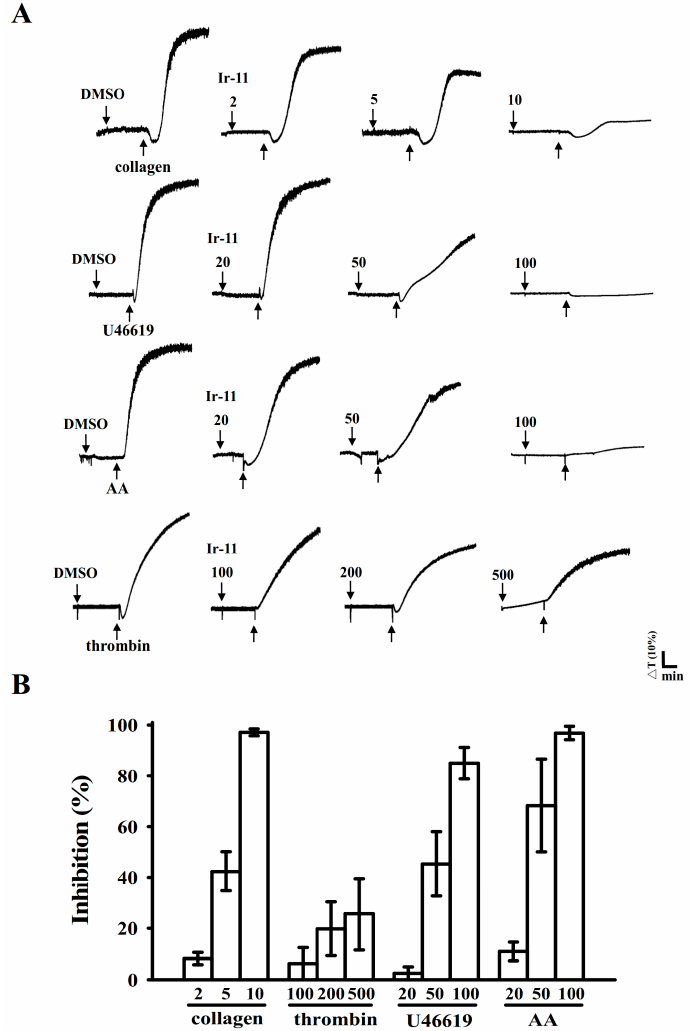
Figure 2. Comparison of the relative inhibitory activity of Ir-11 against platelet aggregation stimulated by various agonists in washed human platelets. ( A ) Washed human platelets (3.6 × 10 8 cells/mL) were preincubated with the solvent control 0.1% DMSO or various concentrations of Ir-11 (2–500 µ M) and subsequently treated with collagen (1 µ g/mL), thrombin (0.01 U/mL), U46619 (1 µ M), and AA (120 µ M) to stimulate platelet aggregation; ( B ) Concentration–response histograms of Ir-11 against platelet aggregation stimulated by agonists. Data are presented as means ± standard error of the mean ( n = 4).